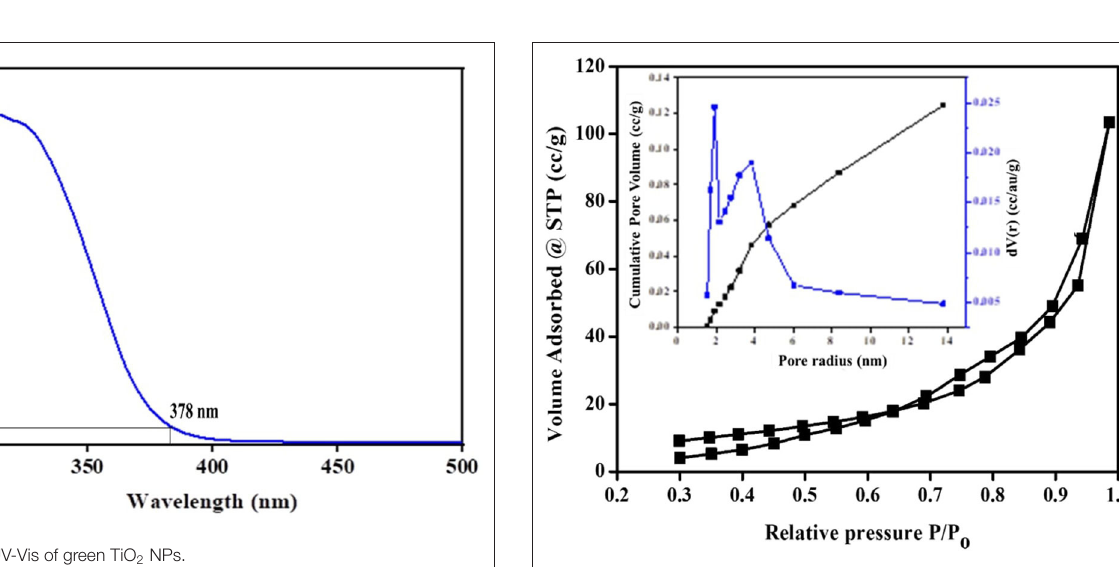
FIGURE 9 | N 2 isotherm and pore size distribution (inset) of the synthesized TiO 2